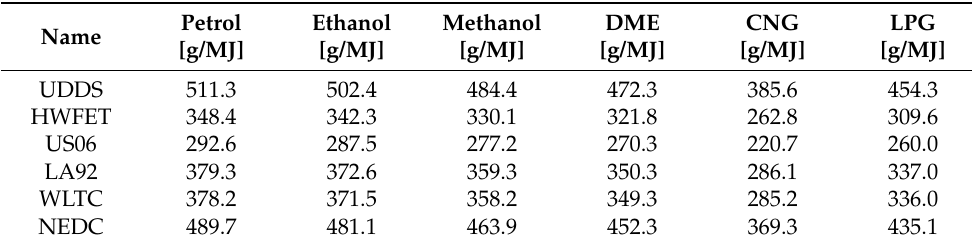
Table 11. Summary of the final CO 2 emissions per 1 MJ obtained from the simulations of the 2018 Toyota Camry LE vehicle for selected road tests.